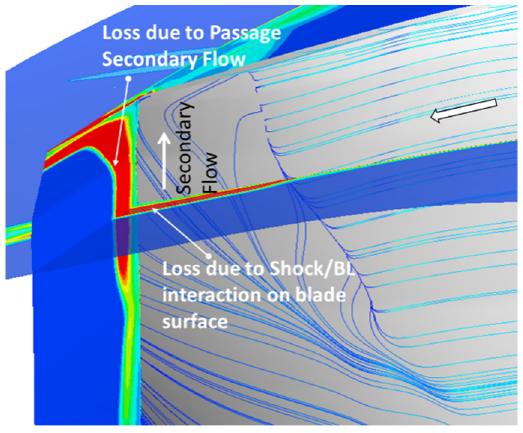
Figure 13. Loss due to the passage secondary flow.